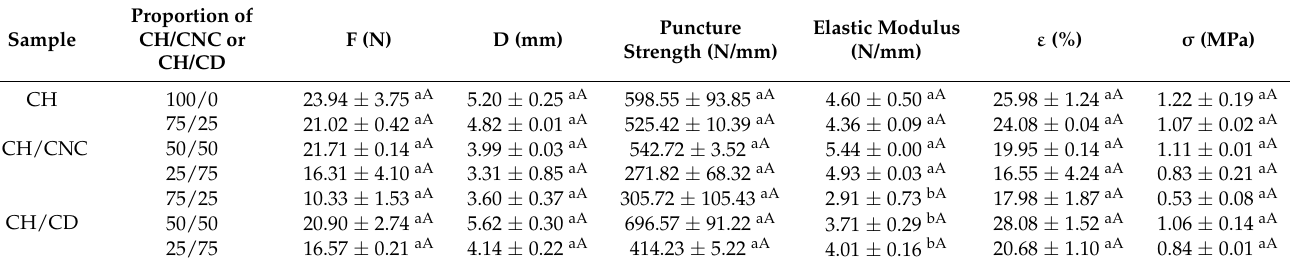
Table 4. Mechanical properties of CH, CH/CNC and CH/CD final formed edible